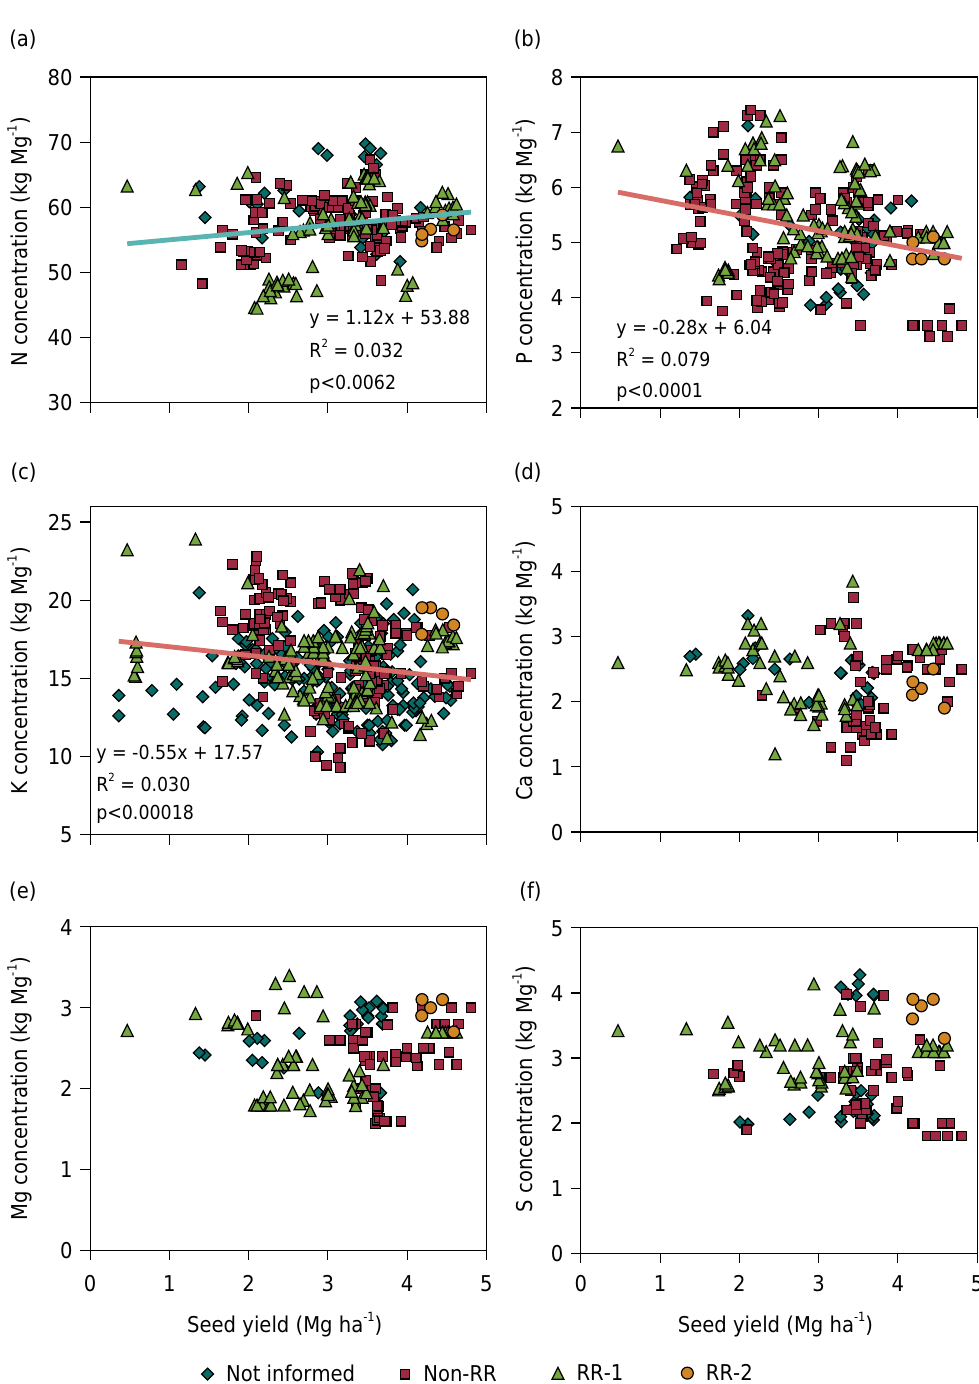
Figure 3. Relationship between soybean yield and seed concentrations of N (a), P (b), K (c), Ca (d), Mg (e), and S (f). Solid blue line represents a positive slope (p<0.05). Solid red line represents a negative slope (p<0.05). Graphs were generated using all available data from field experiments containing nutrient content and soybean yield from 1974 to